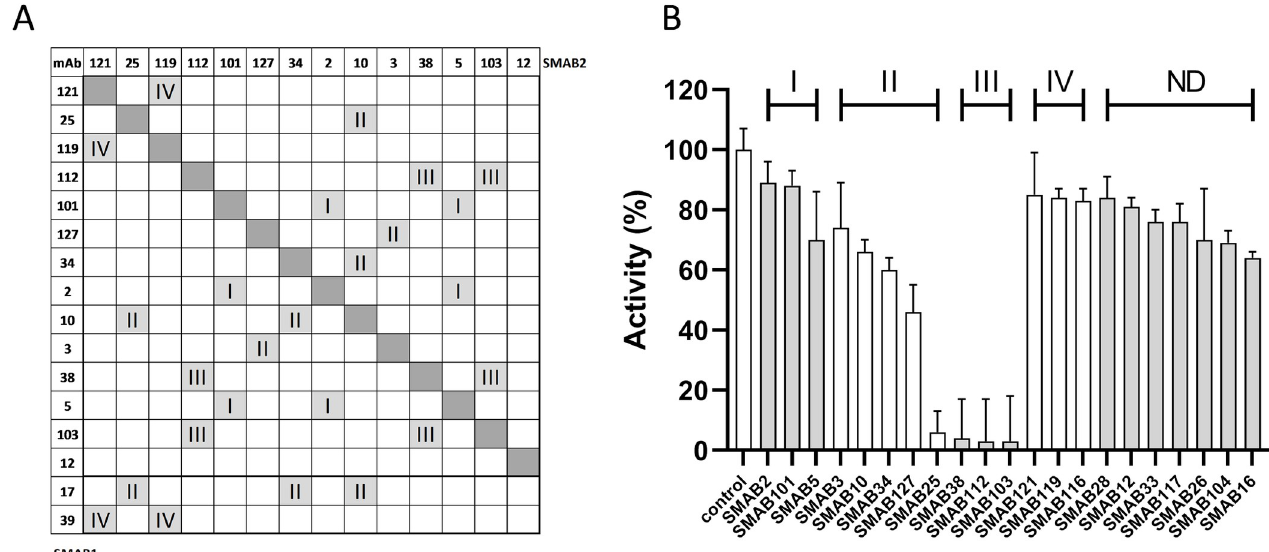
Fig 2. Epitope binning and enzymatic activity inhibition. (A) Epitope binning. The SMAB families identified by epitope binning are indicated with roman numerals. SMAB17 and SMAB39 were tested in one direction only. (B) SMAB inhibition of rhSMOX activity. Activity data were normalized against the control. Data bars represent the average ± std of quadruplicate measurements. With the exception of SMAB 2 and 101, differences for all SMABs were significant with p < 0.05 with respect to the non-inhibited control.